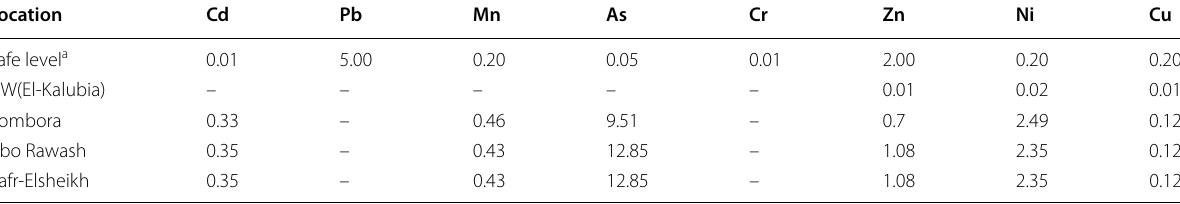
a According to ATSDR (1993)